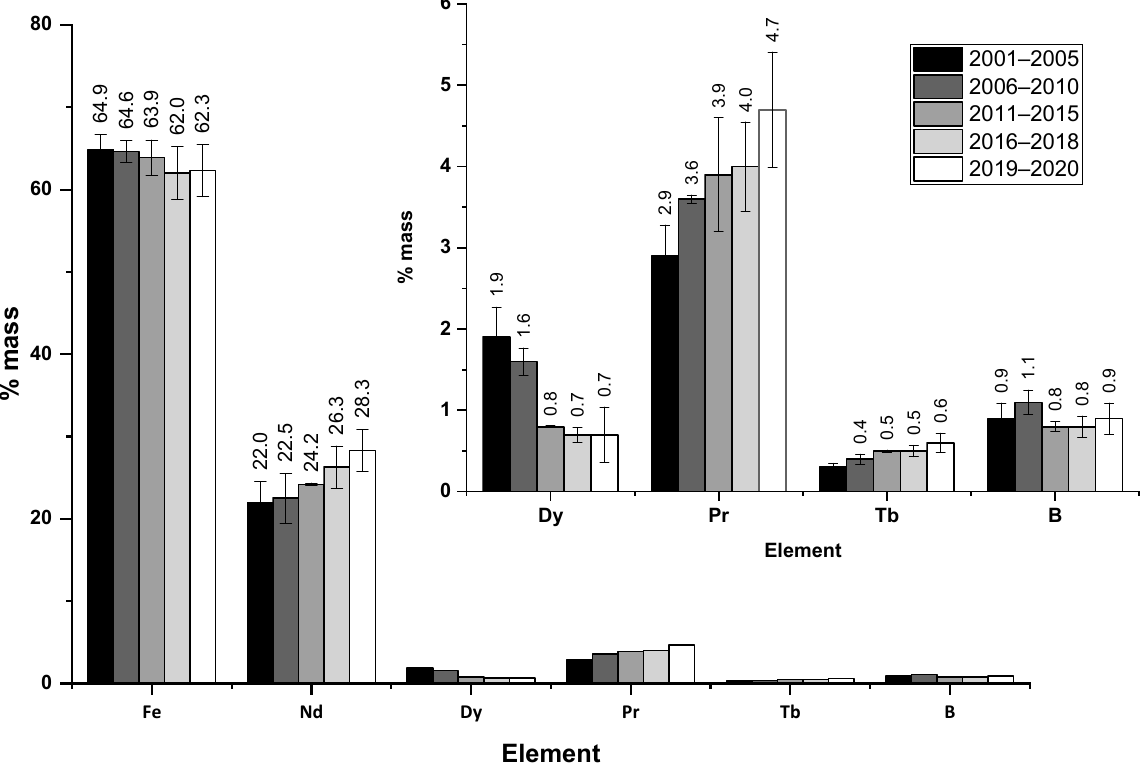
Figure 2. Chemical composition (average) of magnets, over time.